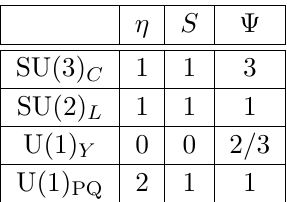
Table 1. Particle contents and their respective charge assignments under different symmetry groups.